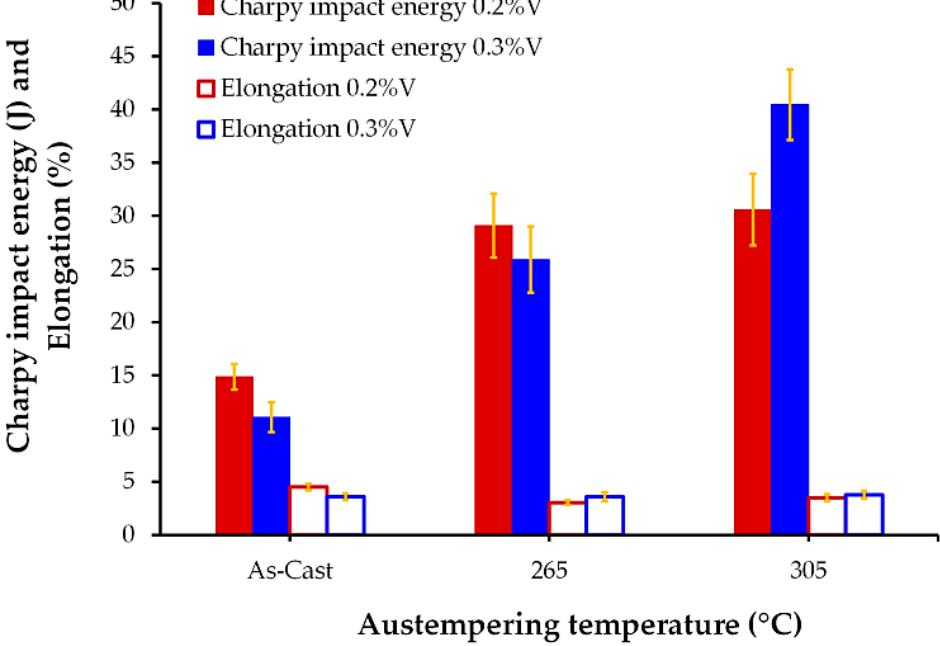
Figure 13. Influence of vanadium content and austempering temperature on the impact energy and elongation.